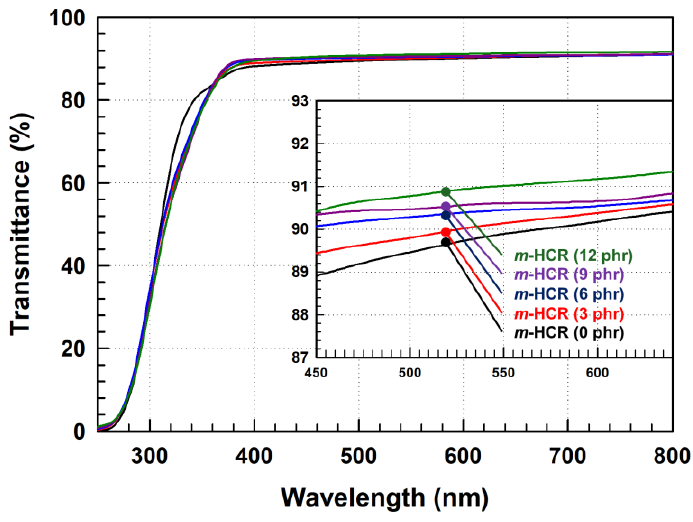
Figure 4. UV/vis light transmittance of the crosslinked neat POE and POE blends with m -HCR.